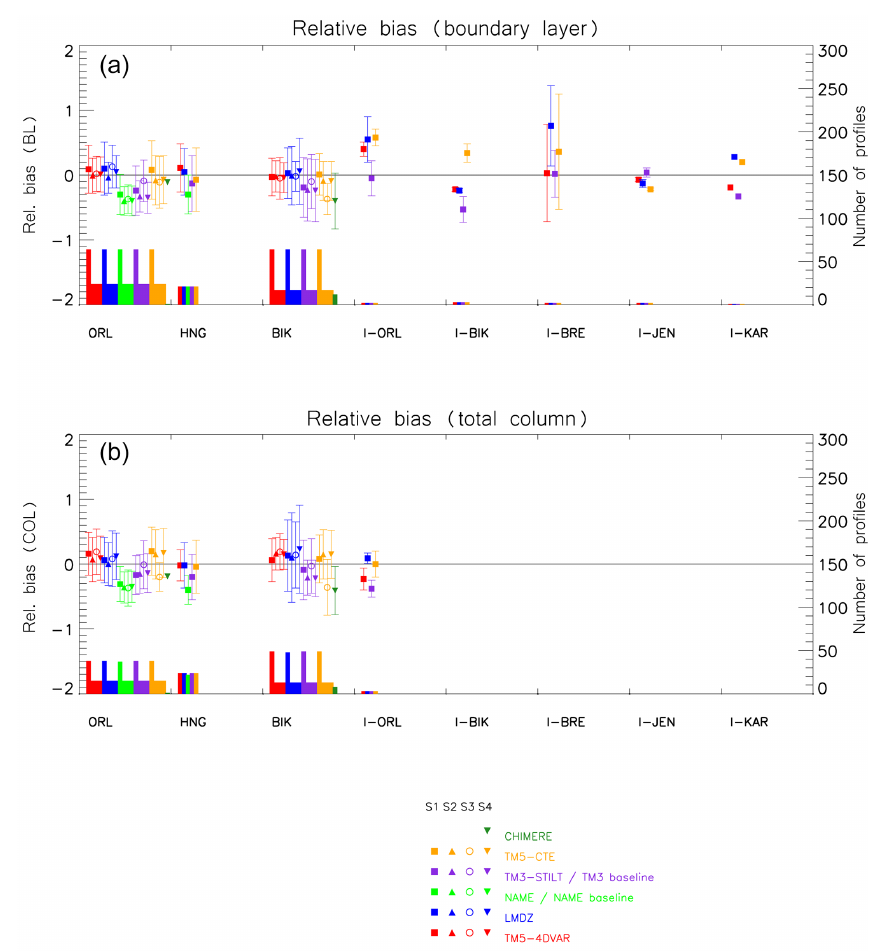
Figure 7. Overview of relative bias at different aircraft sites. (a) Relative bias within the boundary layer (rb BL ) . (b) Column-averaged relative bias (rb COL ) . For NAME the relative bias has been evaluated using the NAME background, for TM3-STILT using the TM3 background, while for all other models the TM5-4DVAR background is used. Numbers of available profiles given as bar graphs (see right